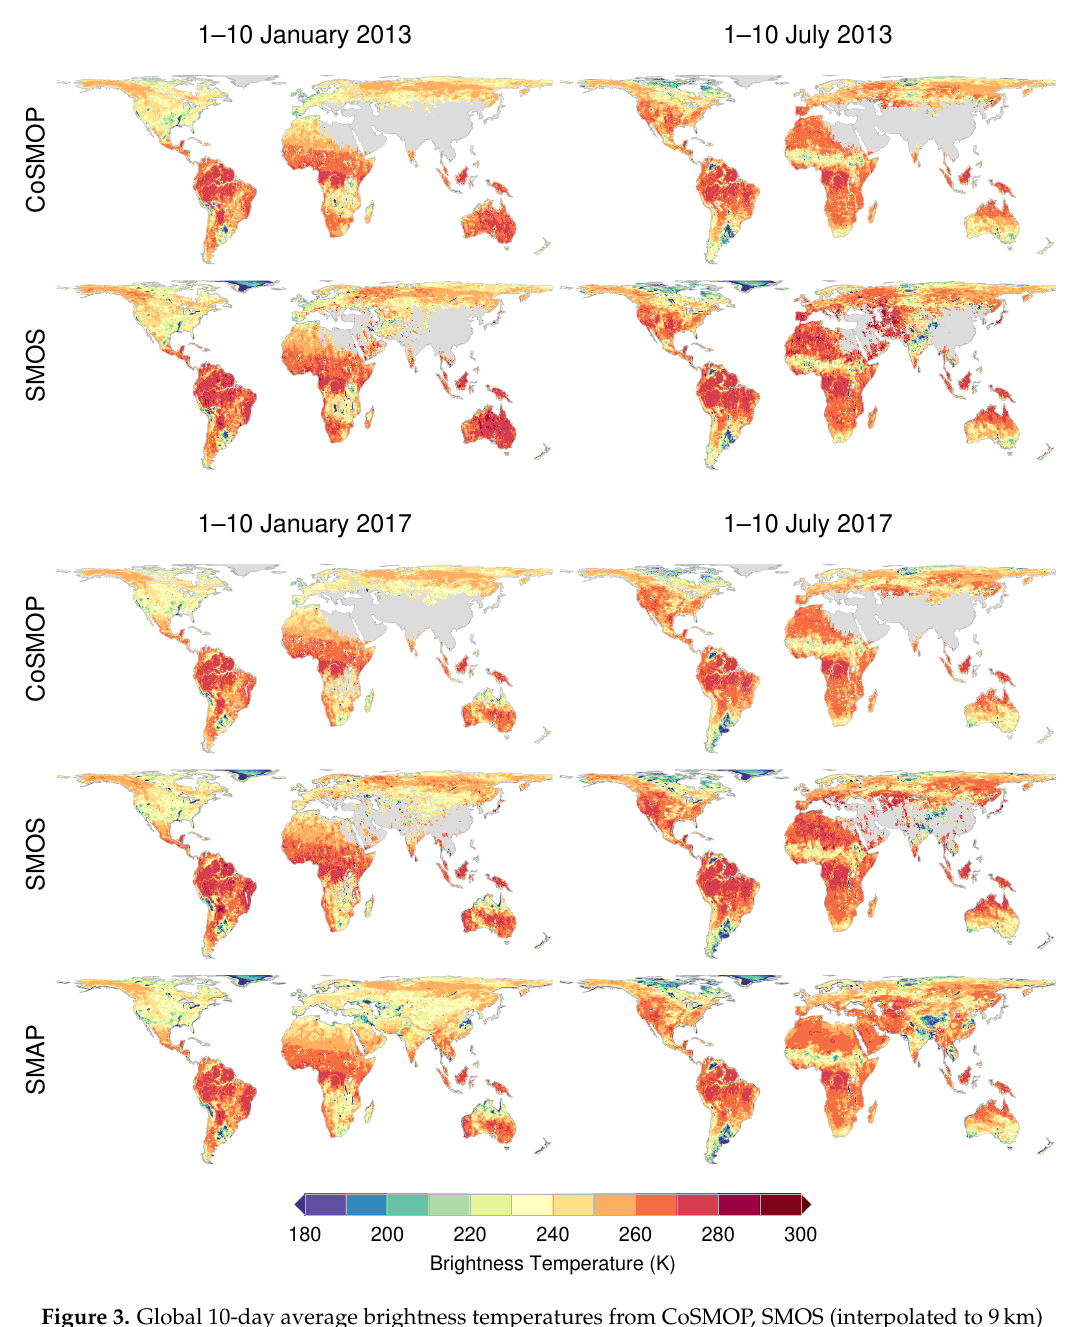
Figure 3. Global 10-day average brightness temperatures from CoSMOP, SMOS (interpolated to 9km) and SMAP_E, computed from 1–10 January 2013 and 2017 (left column) and from 1–10 July 2013 and 2017 (right column) ,